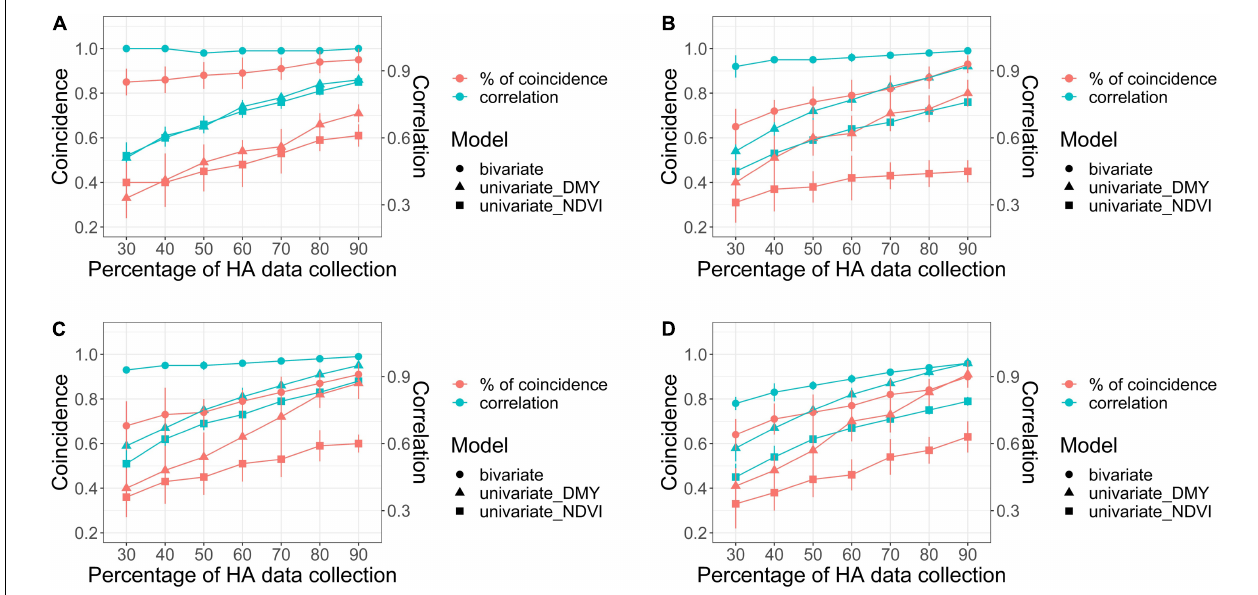
FIGURE 7 | Comparison of bivariate and univariate models (shape) for HA and NDVI for coincidence of selection after applying a 10% selection intensity (red), and correlation among breeding values for all families (green), for scenarios comparing models with increasing levels of HA data collection (30–90%) against a model with